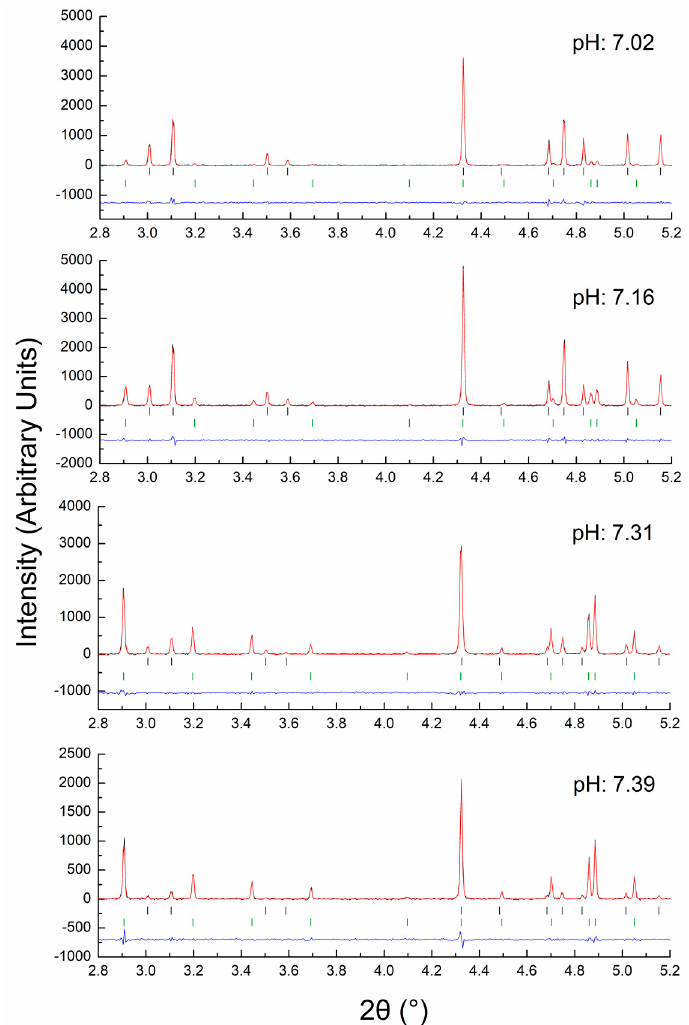
Figure 10. Pawley fits of XRPD data of polycrystalline HI samples exhibiting detectable co-existing molecular polymorphs. Data were collected at ESRF (ID22, RT, λ = 1.29975 (1) Å). The T 6 and T 3 R 3f molecular conformations of rhombohedral ( R 3) crystal phase were identified and refined simultaneously. The black, red and blue lines indicate the experimental data, the calculated profile and their difference, respectively. The black and green vertical bars correspond to Bragg reflections compatible with space group R 3 and molecular conformations of T 6 and T 3 R 3f , respectively.